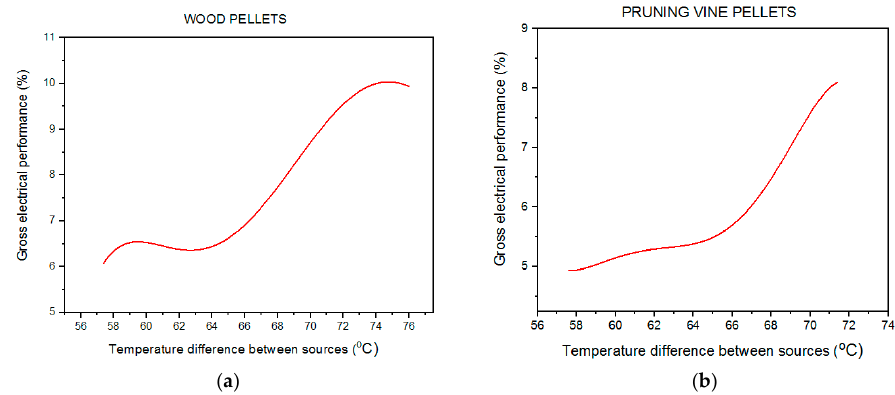
Figure 4. Gross electrical performance of the ORC as a function of the dissipation conditions using pine pellets ( a ) and vine pruning pellets ( b ).